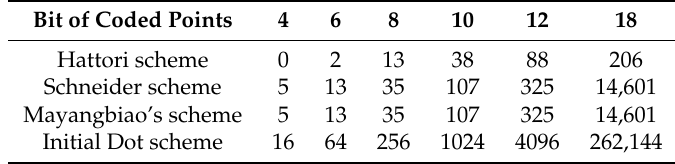
Table 1. Comparison of the number of coded